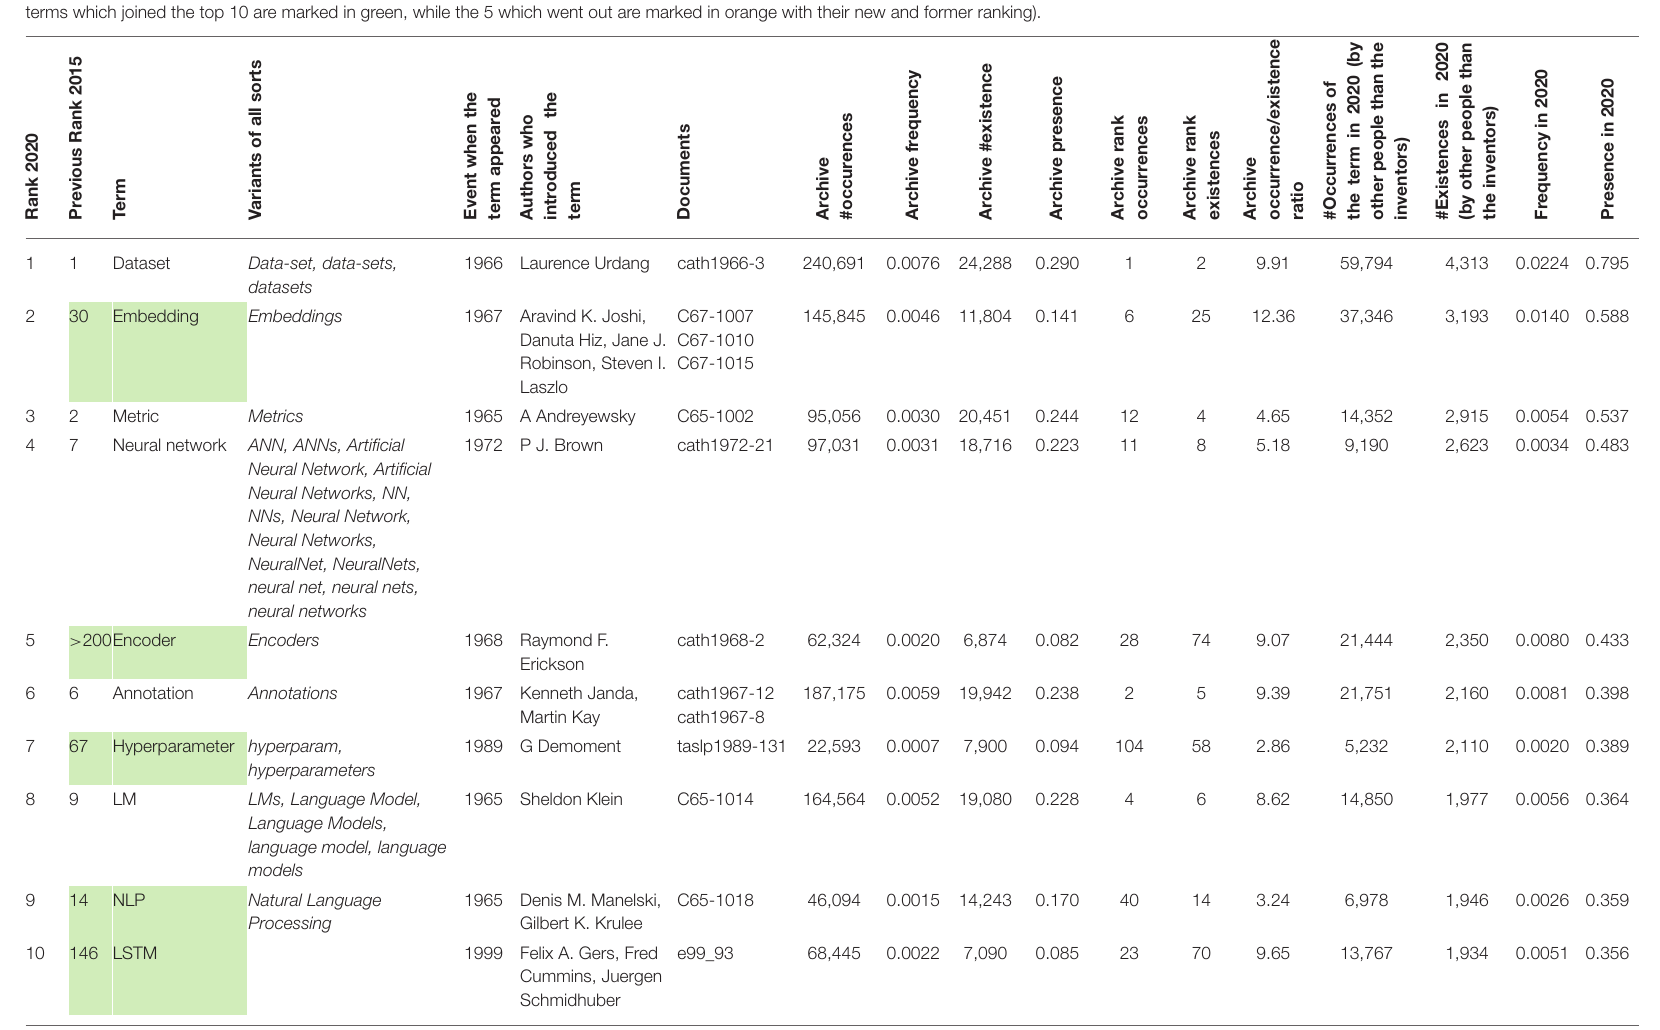
TABLE 25 | The number of 10 most present terms in 2020, with variants, date, authors, and publications where they were first introduced, number of occurrences and existences in 2020, number of occurrences, frequency, number of existences and presence in the 55-year archive, with ranking and average number of occurrences of the terms in the documents where they appear, and comparison with the ranking in 2015 (the terms which joined the top 10 are marked in green, while the 5 which went out are marked in orange with their new and former